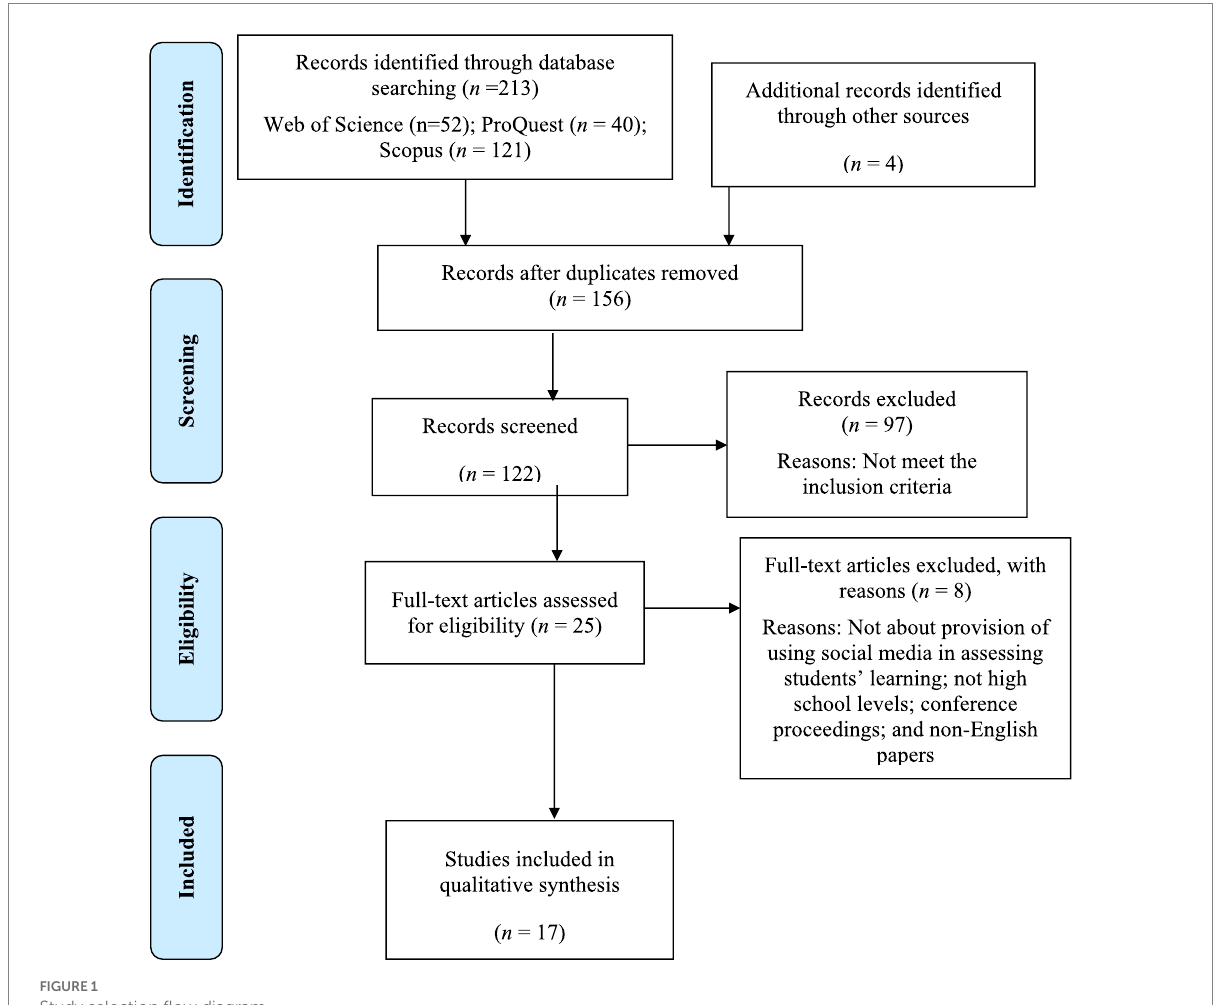
FIGURE 1 Study selection flow